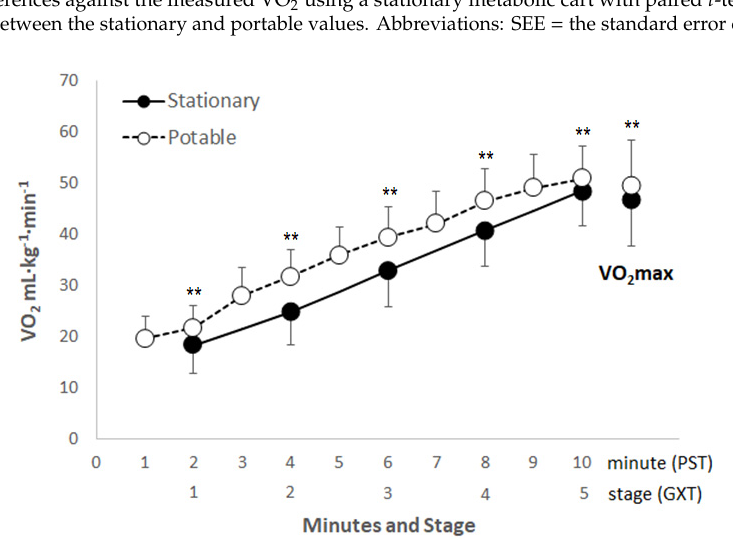
Table 2. Descriptive characteristics (mean ± SD) of the participants in this study.